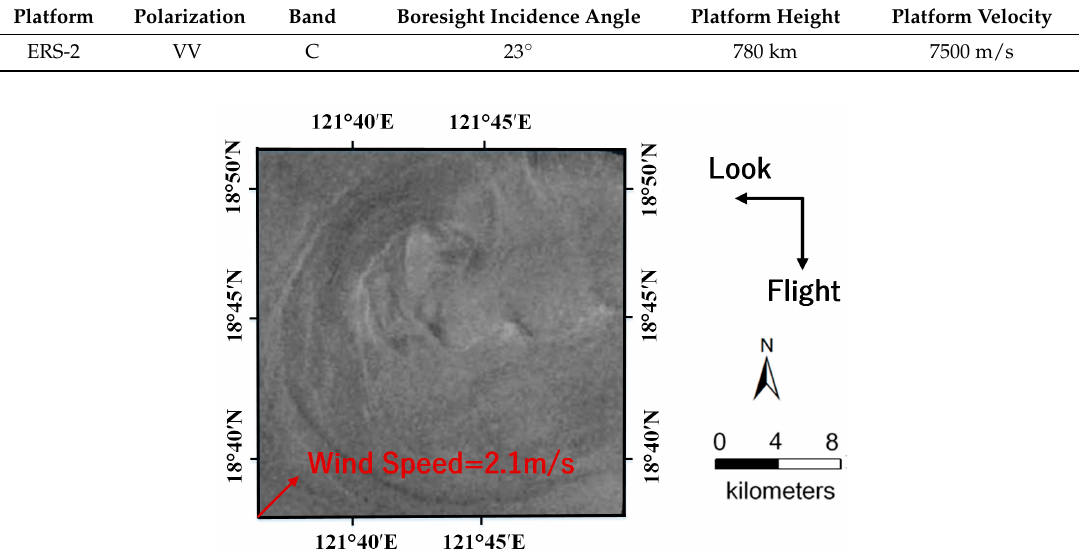
Figure 8. ERS ‐ 2 SAR image of the Luson Strait acquired on 11 June 2010 at 01:25:47 UTC. Frame B (24 km × 24 km) highlights a shear ‐ wave ‐ generated eddy. Table 4. The related parameters of ERS ‐ 2 Synthetic Aperture Radar (SAR).